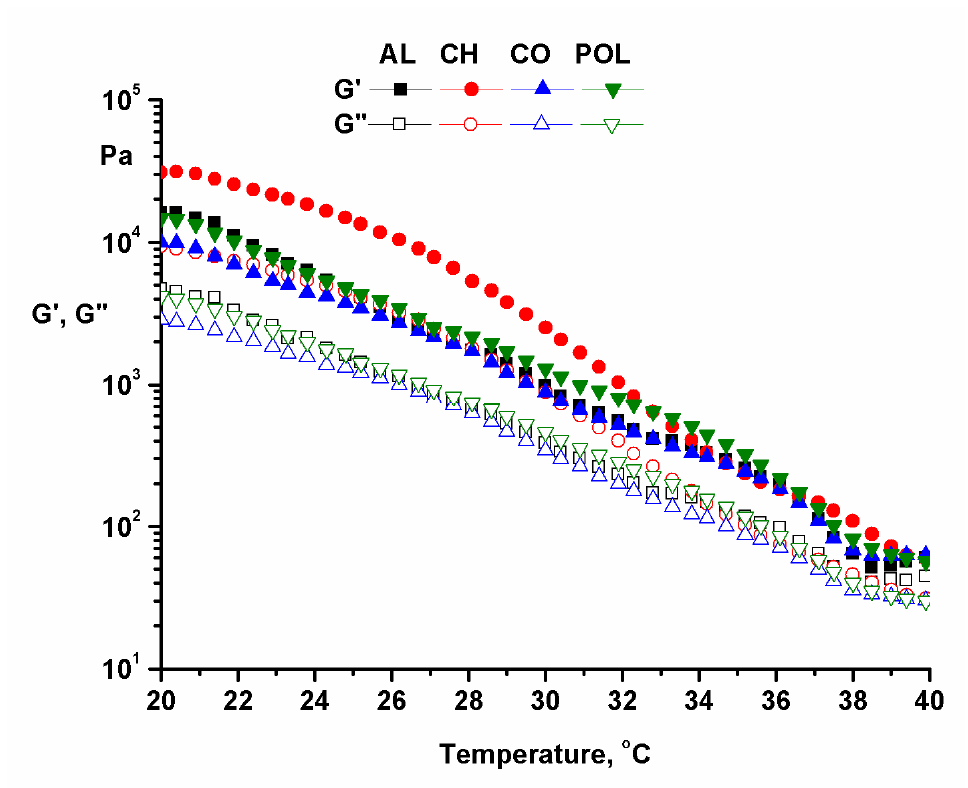
Figure 3. Temperature test in oscillation mode. Rotational tests (Figure 4–flow curves) were performed using a shear variation be- tween 0.001 and 100 s − 1 . The values of zero shear viscosity are listed in Table Table 1. The values of zero shear viscosity (Carreau-Yasuda model). Sample